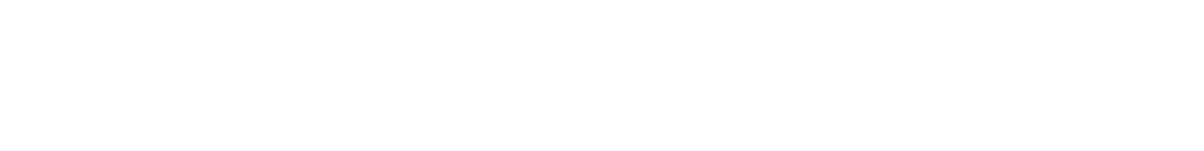
Frontiers in Built Environment |